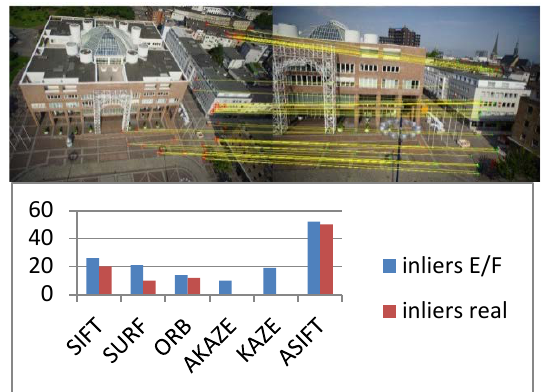
Figure 8: pair-6 results. Upper: SIFT, middle: ORB, lower: for each number of matches after E-/and F-based filtering (blue) and real inliers (red)